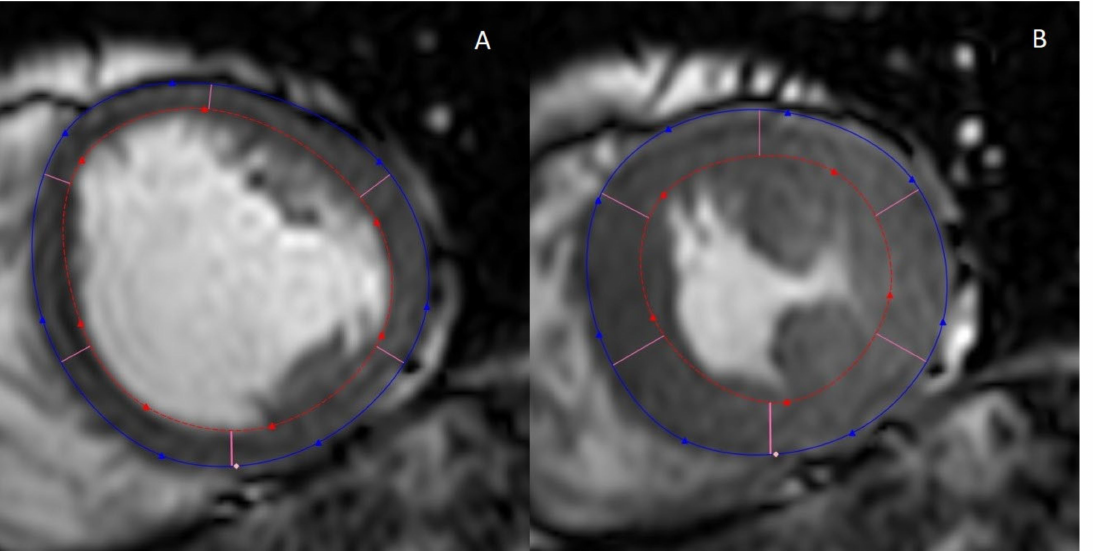
Figure 1. Left ventricular short-axis view of cine MRI. The left ventricle in the ( A ) end-diastolic and ( B ) end-systolic phase. The blue and red lines denote the outer and inner walls of the left ventricle, respectively. Papillary muscles may or may not be included, depending on the individual choice of the researcher/clinician. In this example, they are excluded